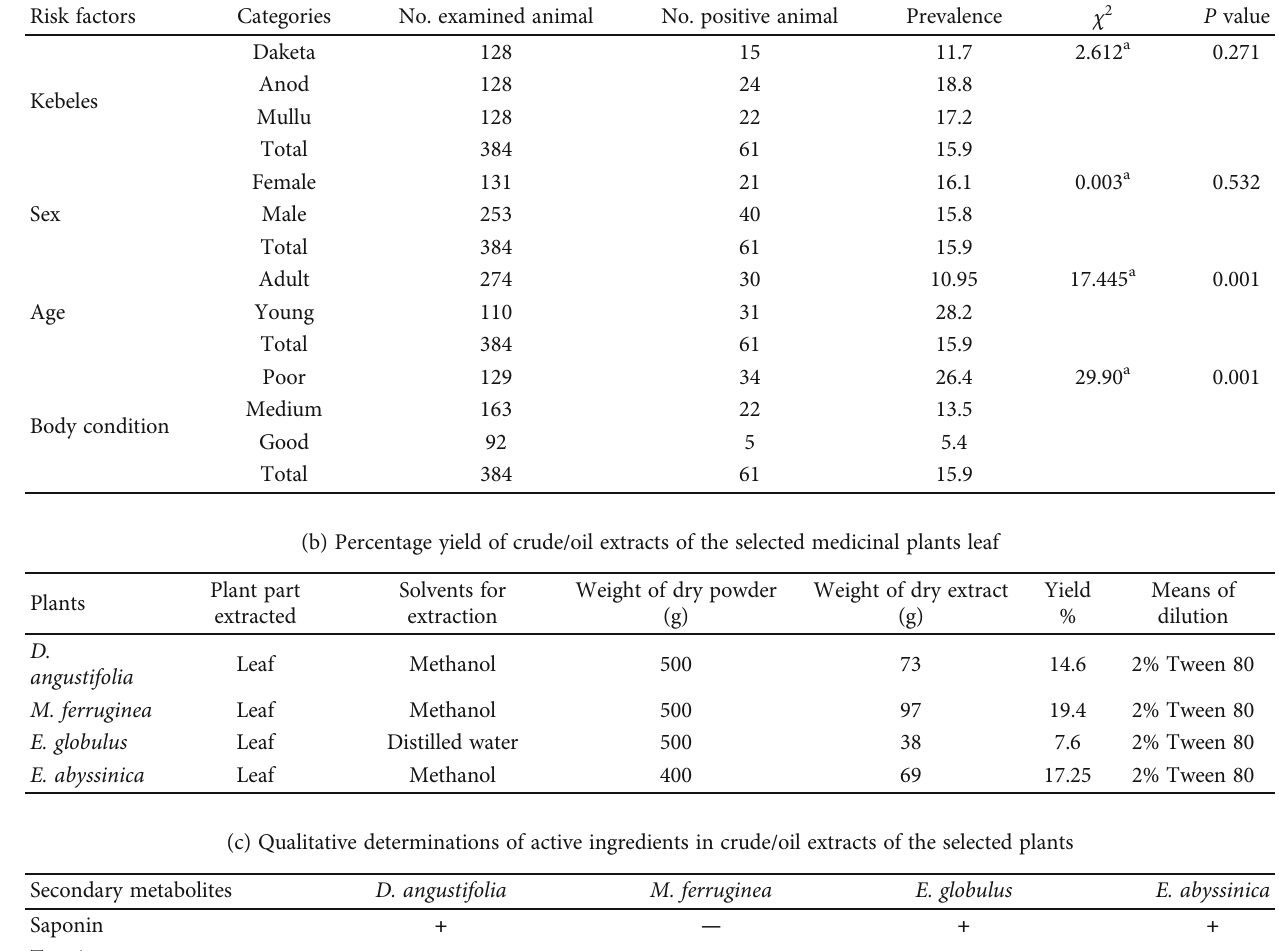
(a) The overall Prevalence of mange mites based on di ff erent risk